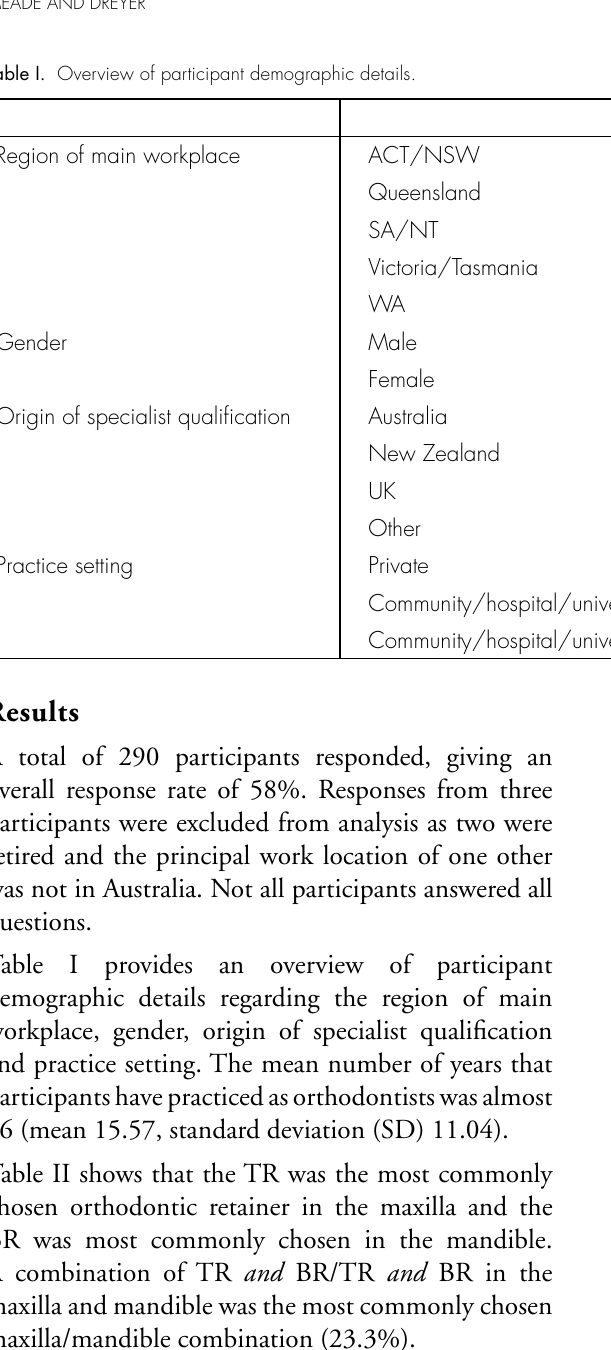
Table I. Overview of participant demographic details.